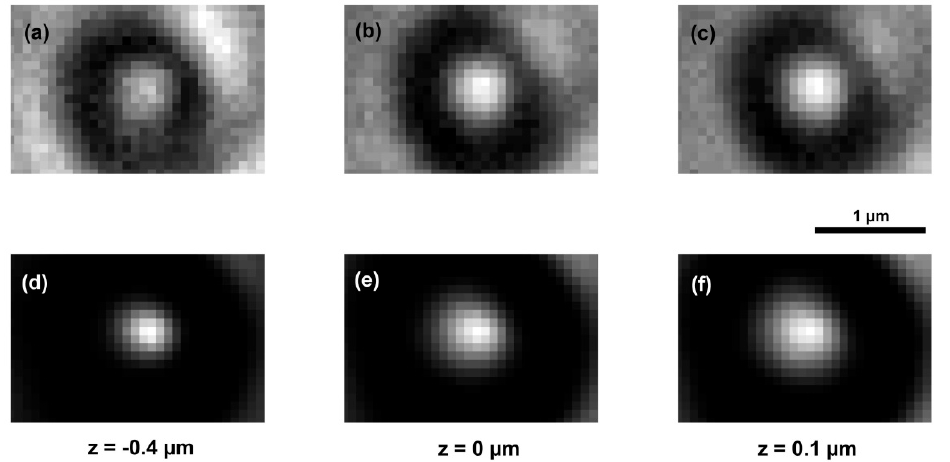
Figure 3. Recorded images in the different planes of a polystyrene microsphere of diameter 1 µm at the wavelength λ = 640 nm ( a – c ), and the corresponding restored images ( d – f ).